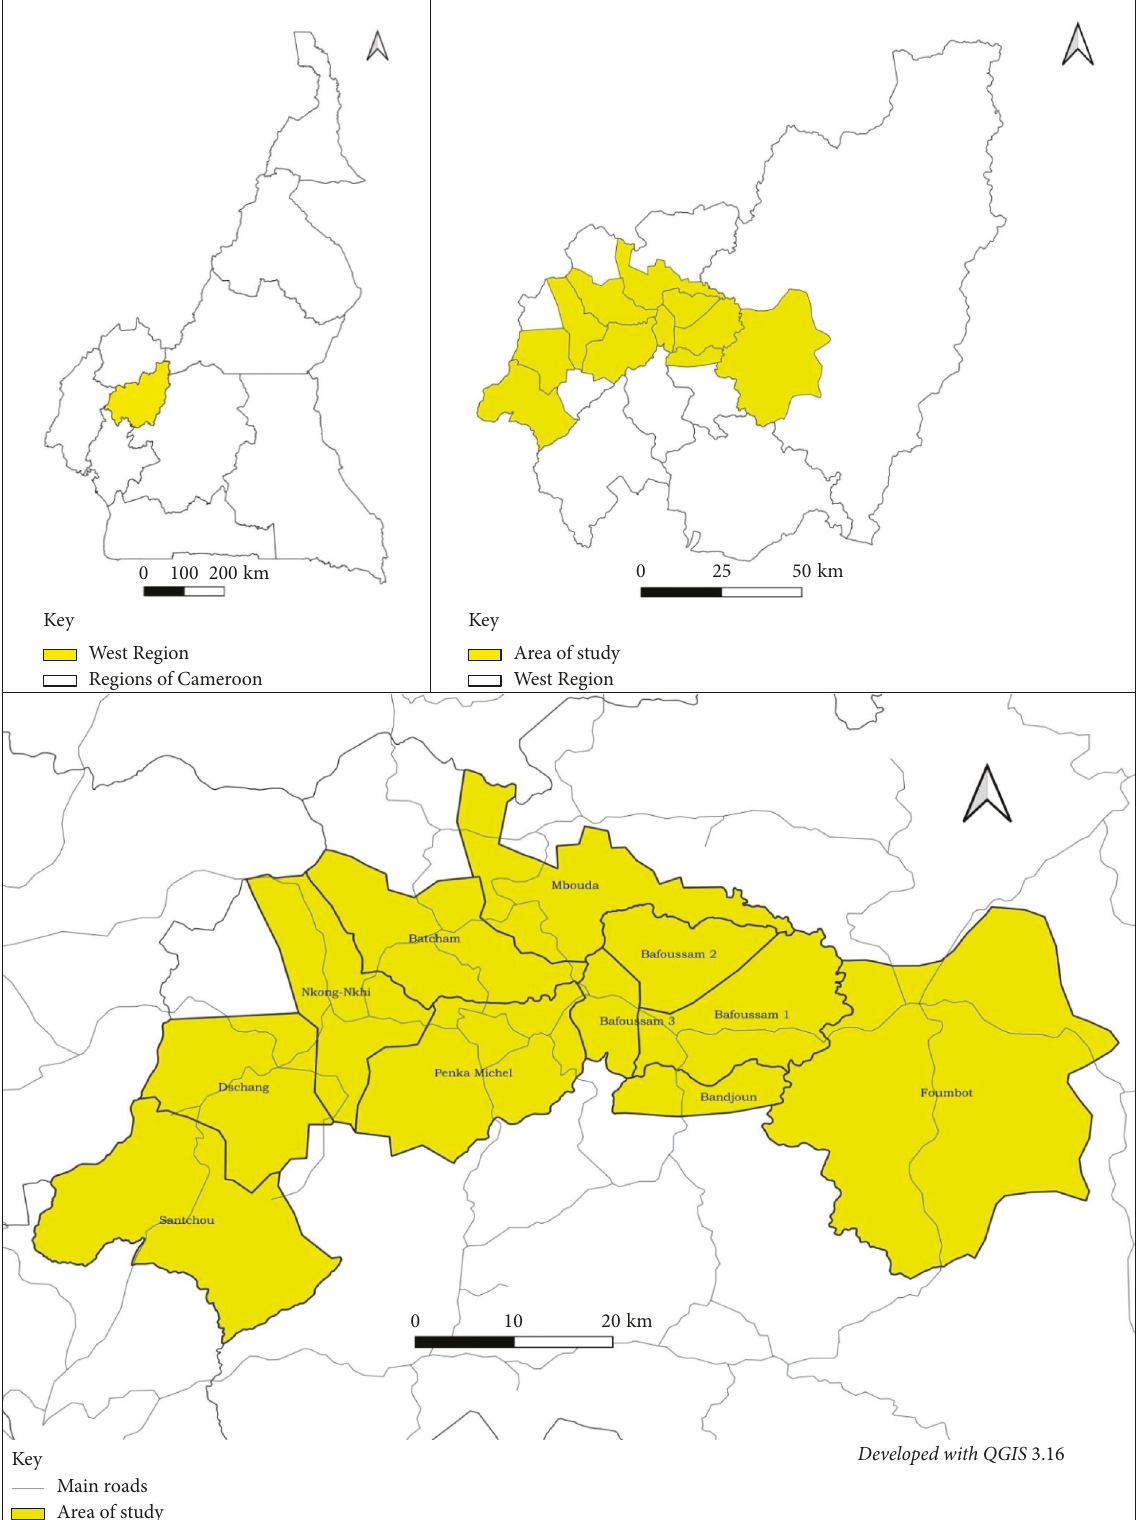
Figure 1: Localisation of the study